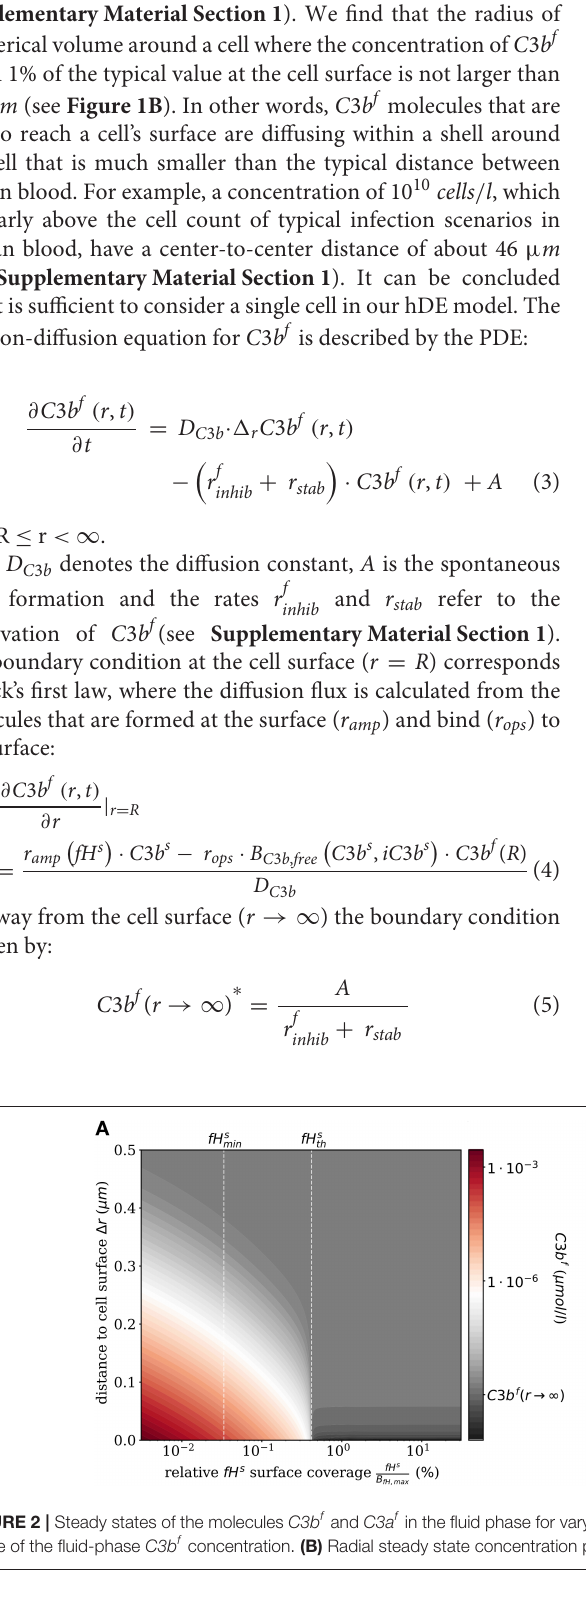
Frontiers in Immunology |